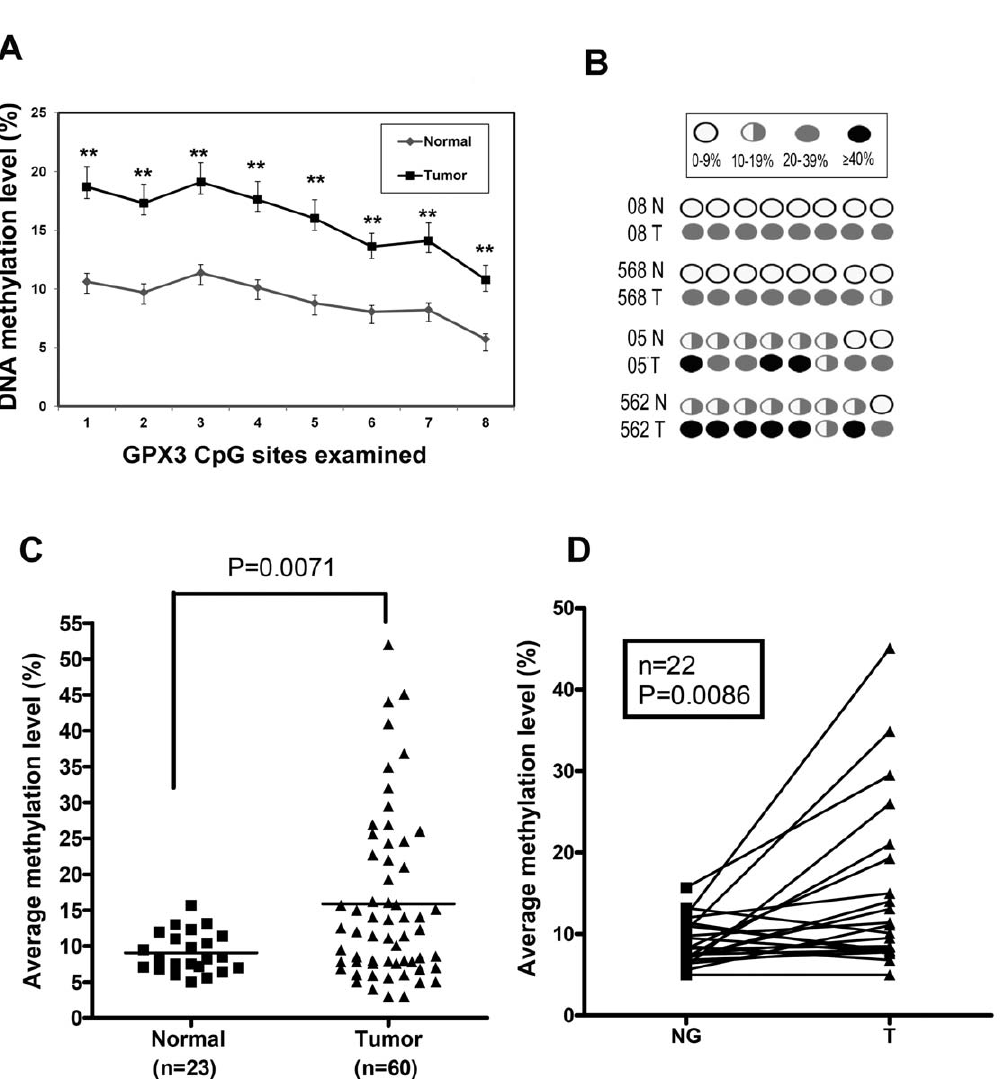
Figure 2. GPX3 promoter was hypermethylated in gastric cancers. DNA methylation level of 8 CpG sites in the GPX3 promoter was quantitated by Pyrosequencing. (A) A schematic profile of GPX3 methylation of the 8 CpG sites was examined in 4 matched normal (N) and tumor (T) samples. (B) The DNA methylation level of each of the 8 CpG sites in 23 normal samples and 60 tumor samples were measured. * P , 0.01. (C) The average DNA methylation level of the 8 CpG sites in 23 normal samples and 60 tumor samples is shown. (D) The average DNA methylation level of the 8 CpG sites in 22 matched normal and tumor samples from the same patients is indicated.